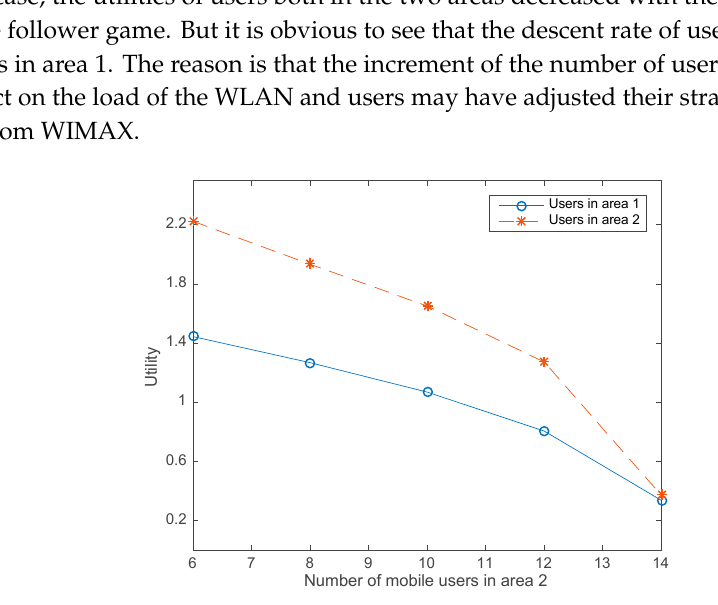
Figure 7. Utility of the mobile user in either area 1 or area 2 with the number of users in area 2.